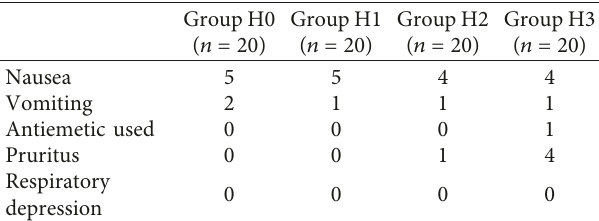
Table 3: Side effects in the 24 hours after